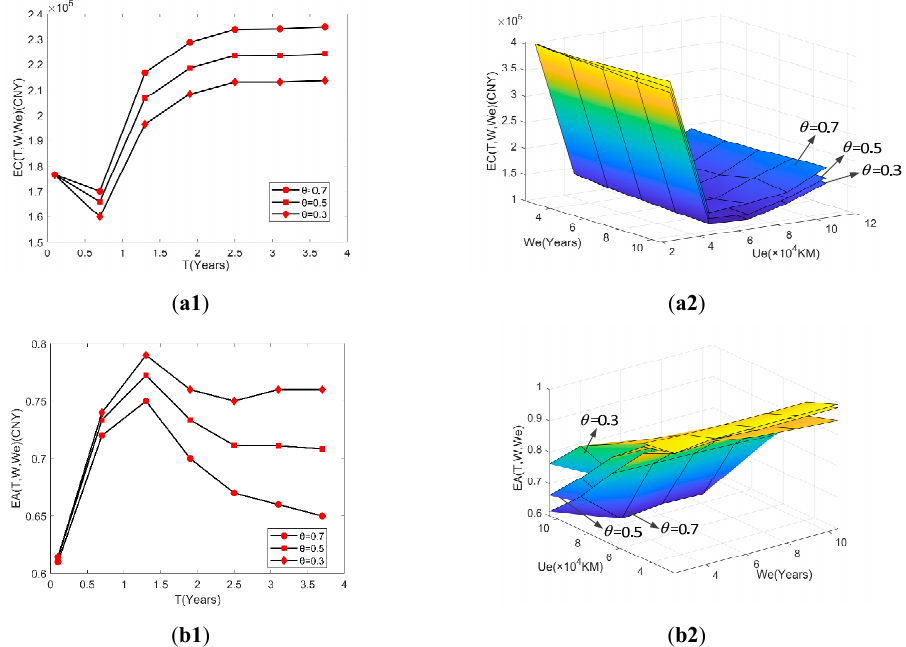
Figure 15. Sensitivity analysis of θ . ( a1,a2 ) Warranty cost as a function of the change in θ . ( b1,b2 ) Availability as a function of the change in θ .